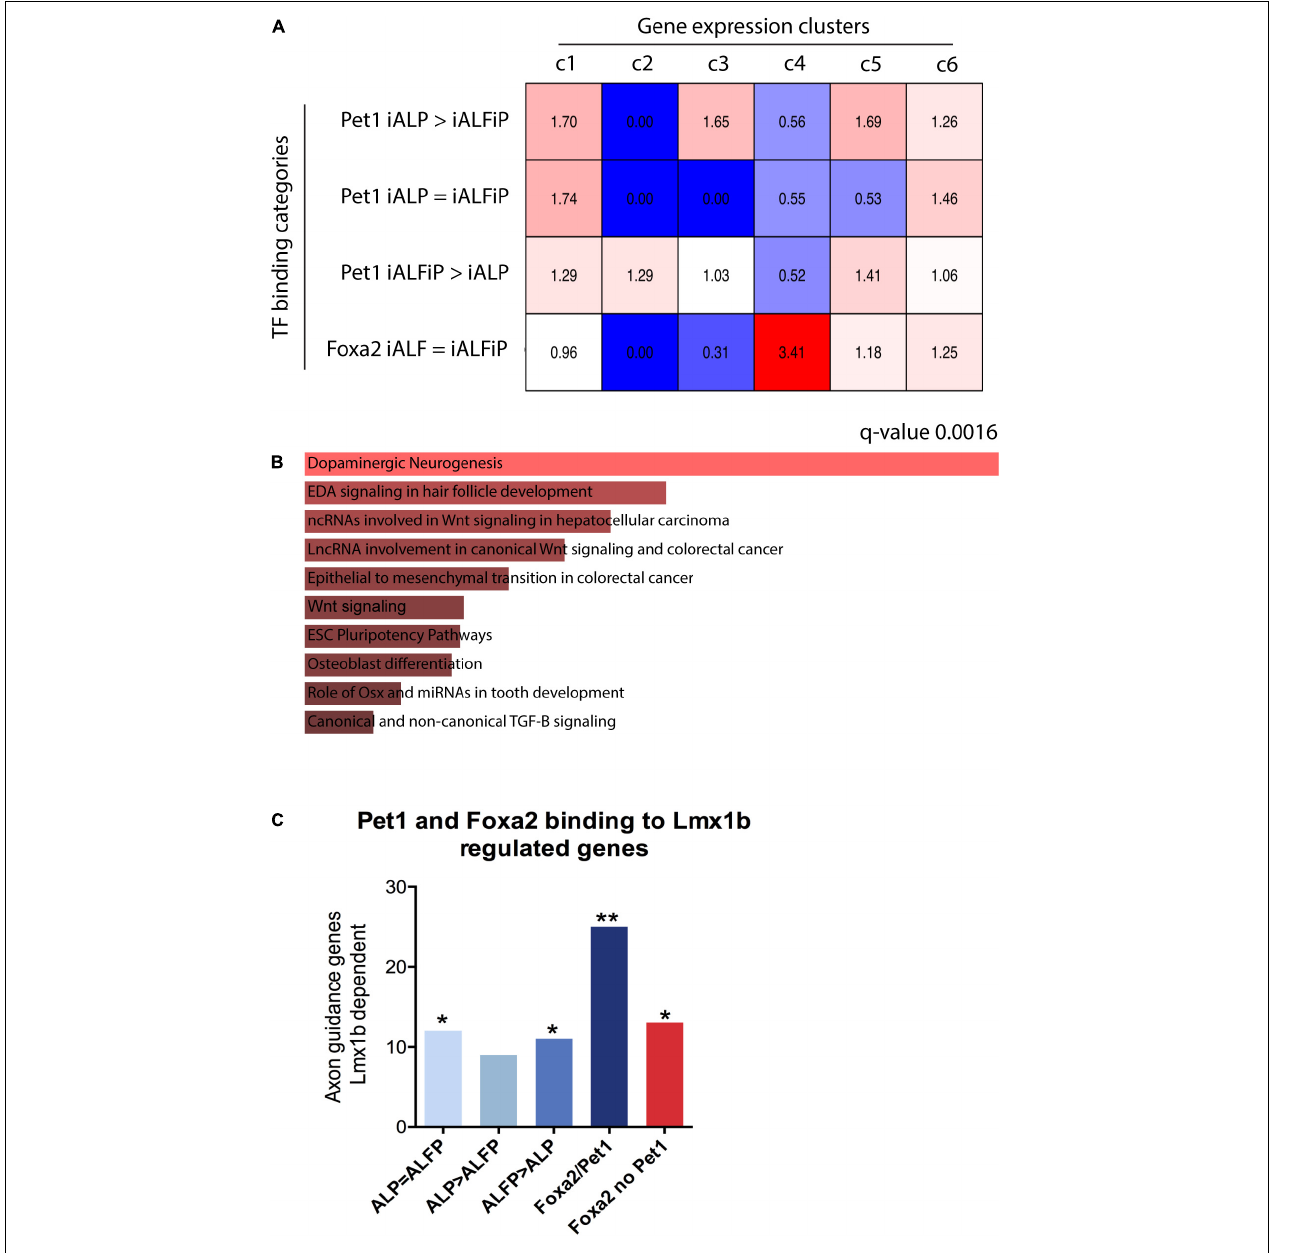
FIGURE 7 | (A) Overlap between bulk RNA-seq clusters from Figure 2 48 h and transcription factor binding sites from ChIP-seq experiments. Numbers represent over- and under-representation factors compared with randomly selected regions. (B) Gene Ontology analysis for genes bound by Foxa2 in cluster 4 shows enrichment for dopaminergic neurogenesis. (C) Overlap between specific binding categories and known serotonergic targets of Lmx1b shows that genes associated to Foxa1/Pet1 co-bound sites are highly enriched for serotonergic functions. * p < 0.5, ** p <